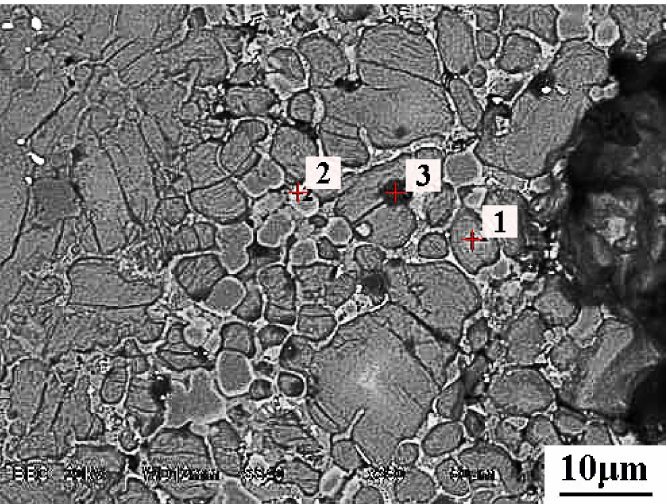
Figure 9. SEM micrograph (backscattered electron) of the dephosphorization slag in Heat